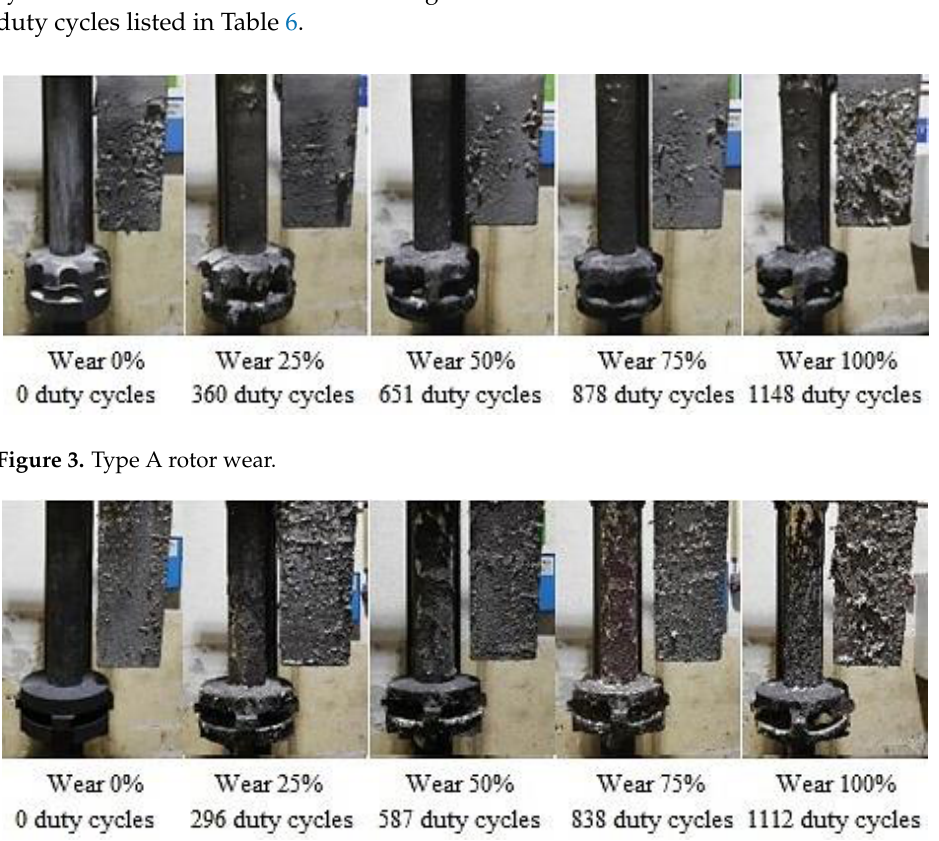
Figure 4. Type B rotor wear.